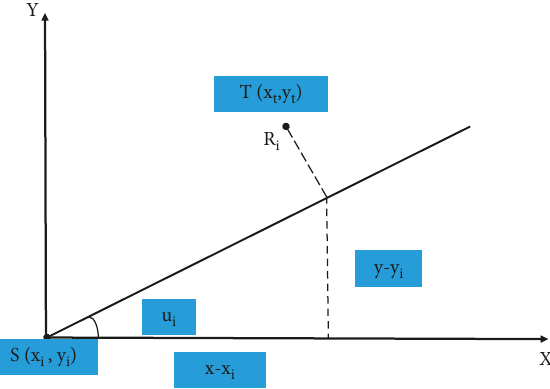
Figure 7: Schematic diagram of DF positioning